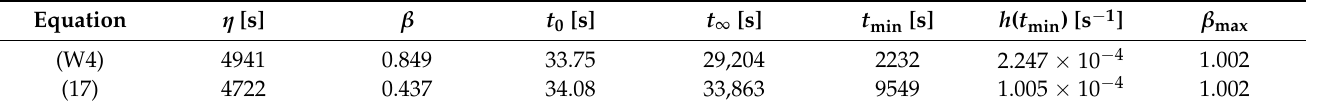
Table 1. Parameters of the (W4) CDF determined from the Weibull plot and empirical HR fit supplemented by the positions of the minima of the HR curves and the limit values of the β